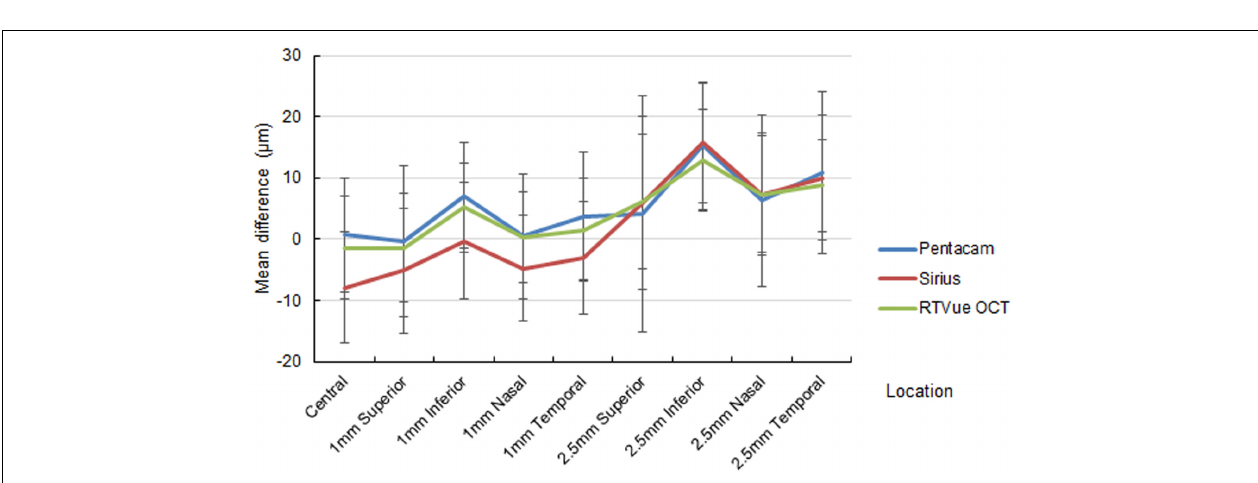
FIGURE 1 | Mean difference of the predicted ablation depth against actual measured corneal ablation depth determined by Pentacam HR (blue line), Sirius (red line), and RTVue OCT (green line) at one month postoperatively.